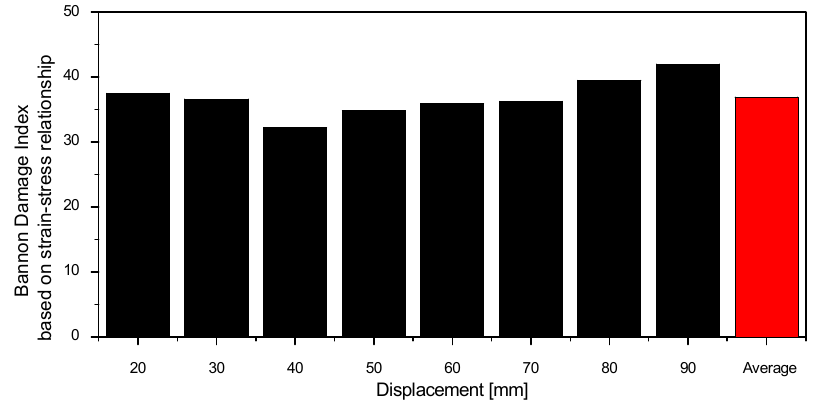
Figure 6. Damage index of a carbon steel pipe elbow.